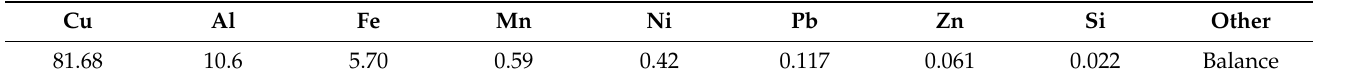
Table 2. Chemical composition in percentages (wt%) of Cu-10Al-5Fe